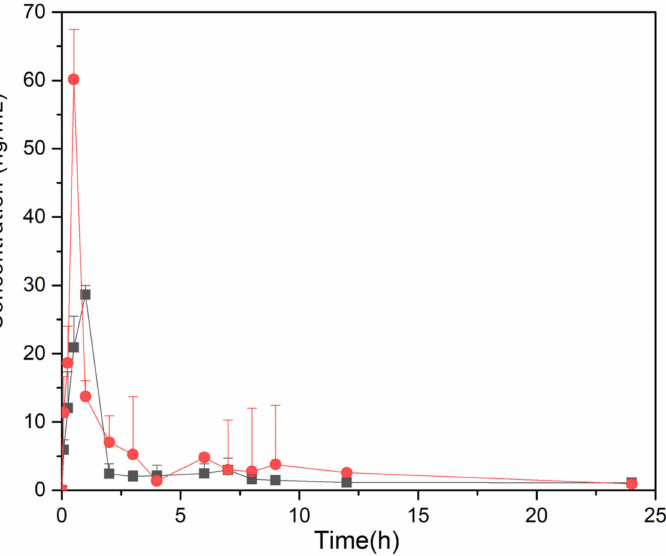
Figure 10. Plasma concentration-time curves after oral administration of G-Re powder ( (cid:4) ) and G-Re- γ -CD IC ( •